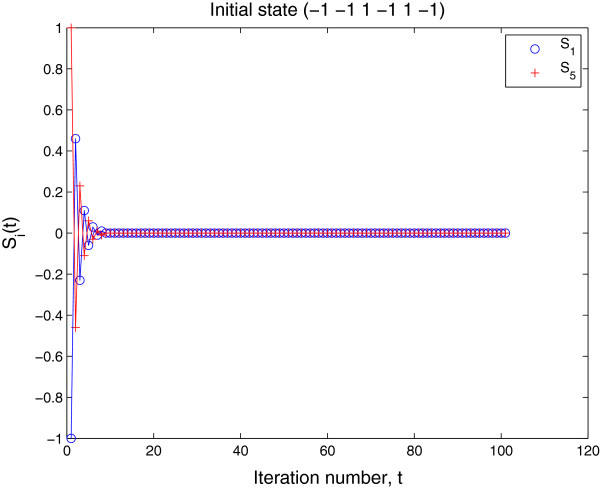
Projection of trajectory onto two-dimensional (S1,S5)-subspace starting from initial state (−1 −1 1 −1 1 −1) converging to final state 0 (Example 4).